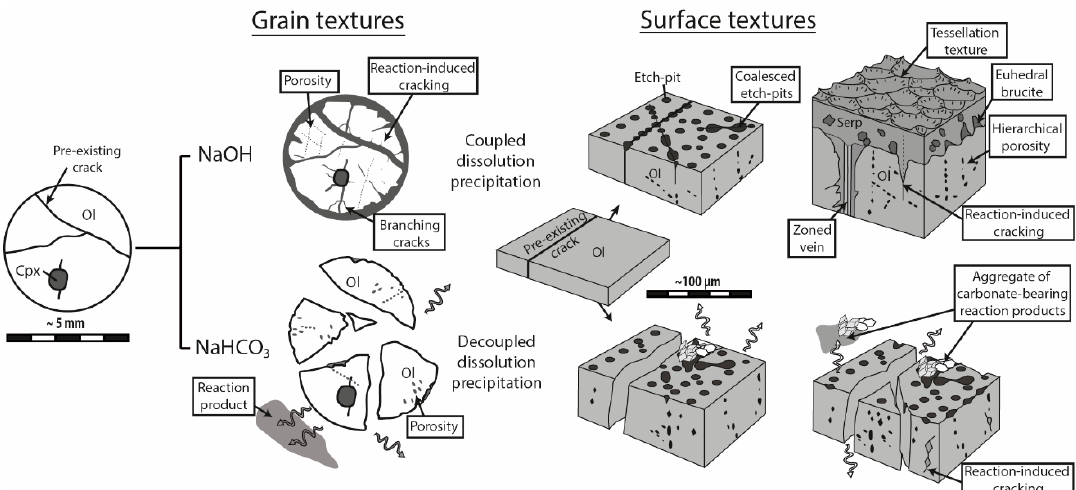
Figure 10. Sketch summarizing the distinct grain and surface features observed after reaction in NaOH and NaHCO 3 solutions. Note the very different degree of spatial coupling between dissolution and precipitation in each reaction type Cpx: clino-pyroxene, Ol: olivine, Serp: serpentine.